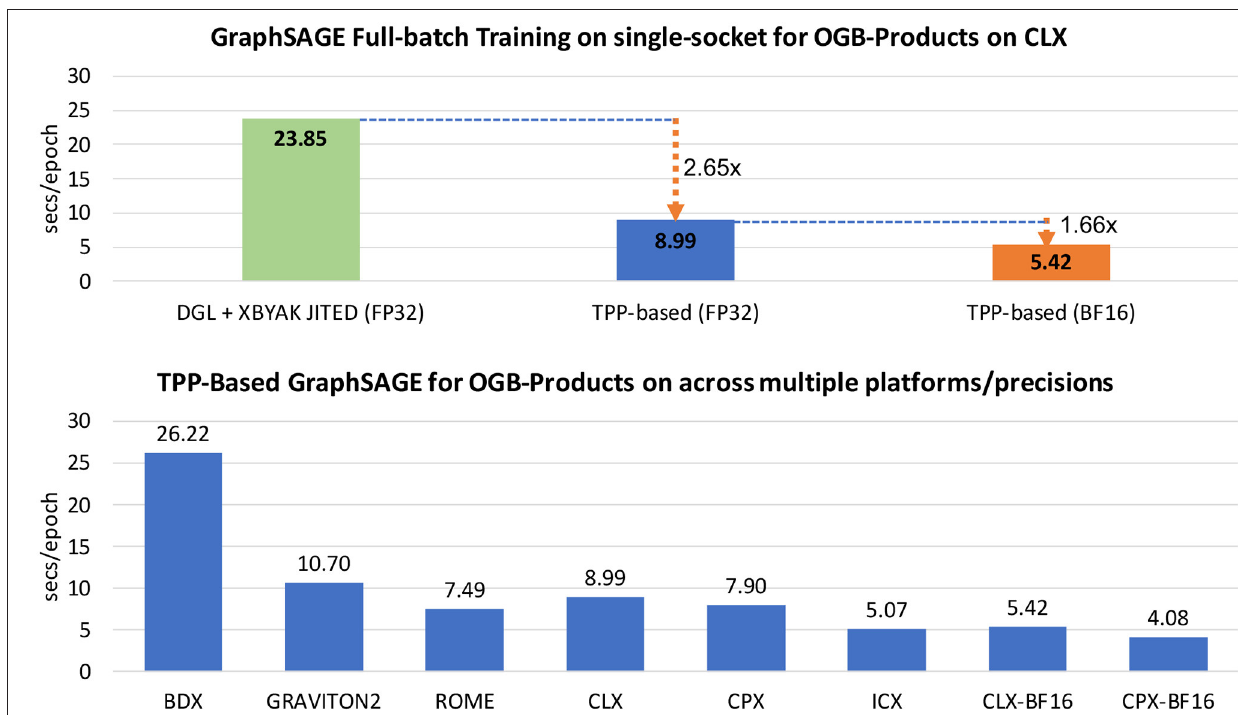
version by 2.65 × . The TPP-BF16 version yields another 1.66 × speedup over the TPP-FP32 variant mainly due to reduced bandwidth